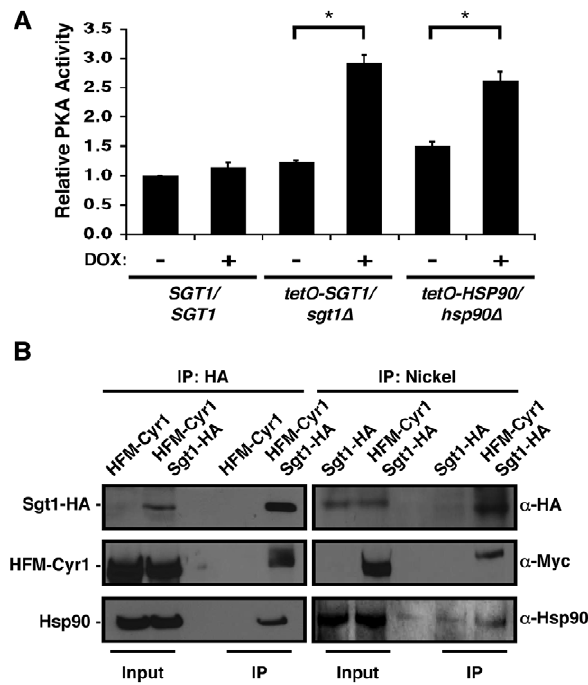
Figure 3. Depletion of Sgt1 activates cAMP-PKA signaling, and Sgt1 interacts with the adenylyl cyclase Cyr1. (A) Depletion of Sgt1 activates cAMP-PKA signaling. PKA activity was measured for cell extracts derived from the indicated strains. Sgt1 or Hsp90 levels were reduced by growth overnight in 20 m g/ml doxycycline, followed by subculture in fresh medium with 20 m g/ml doxycycline and growth until mid-log phase. Data are normalized against the level of PKA activity of wild type cell extracts, and are displayed as means 6 standard deviations for triplicate samples. * Indicates P , 0.01, ANOVA. (B) Sgt1 and Cyr1 physically interact as measured by reciprocal co- immunoprecipitation of epitope-tagged proteins. Left panel, immuno- precipitation of Sgt1-HA with anti-HA agarose co-purified 6x-His-FLAG- Myc (HFM)-Cyr1, while HFM-Cyr1 did not immunoprecipitate with anti- HA agarose in control cells harbouring only untagged Sgt1. Hsp90 also co-purified with Sgt1-HA, and was not purified in the controls with only untagged Sgt1. Right panel, immunoprecipitation of HFM-Cyr1